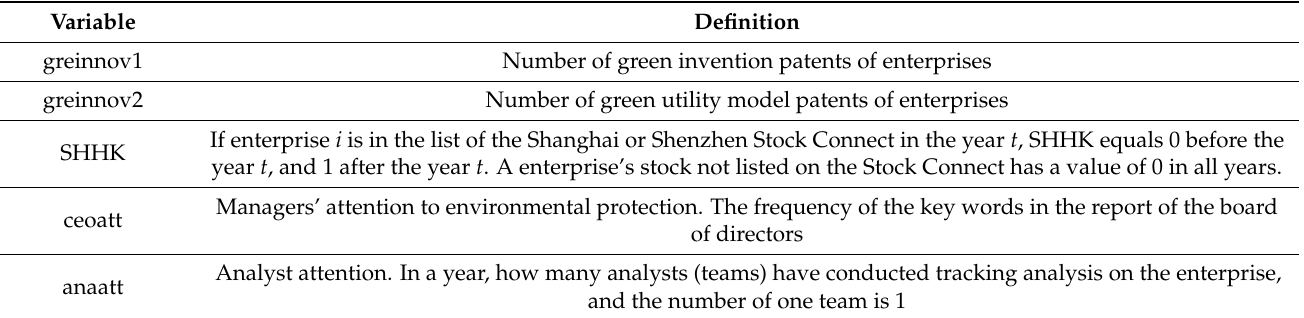
Table A1. Specifications of